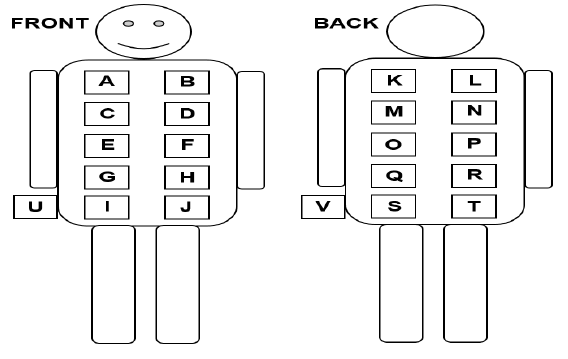
Figure 4. The proposed nodes’ locations on the front and back of the